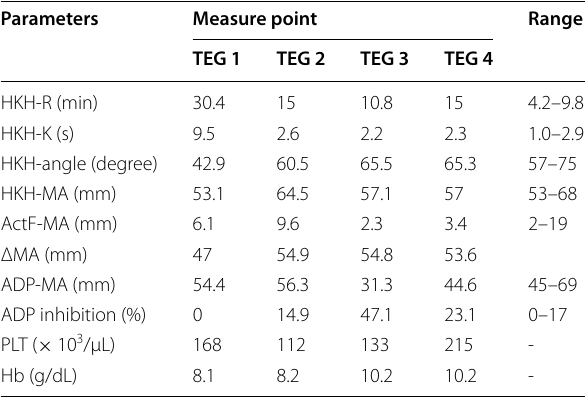
TEG1, TEG2, TEG3, and TEG4 represent preoperative, pre-cardiopulmonary, post- cardiopulmonary, and postoperative measurements, respectively. Abbreviations : TEG Thromboelastography, HKH Heparinized kaolin with heparinase, R Reaction time, K Coagulation time, angle α angle, ActF Activator F, MA Maximum amplitude, ADP Adenosine diphosphate, PLT Platelet, Hb Hemoglobin